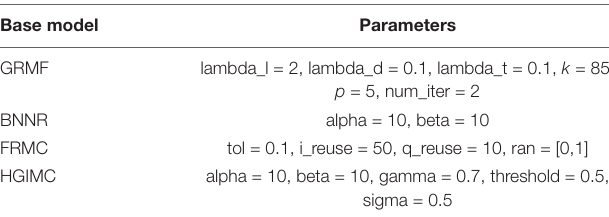
TABLE 2 | Parameters